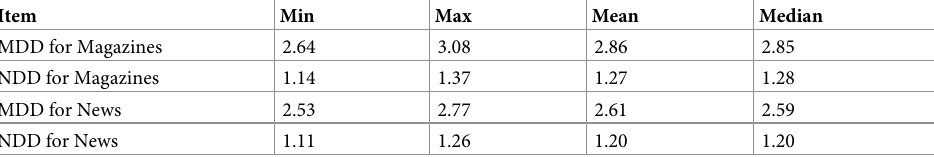
Table 4. Observed MDD/NDD polynomial regression min/max/average/median values description.